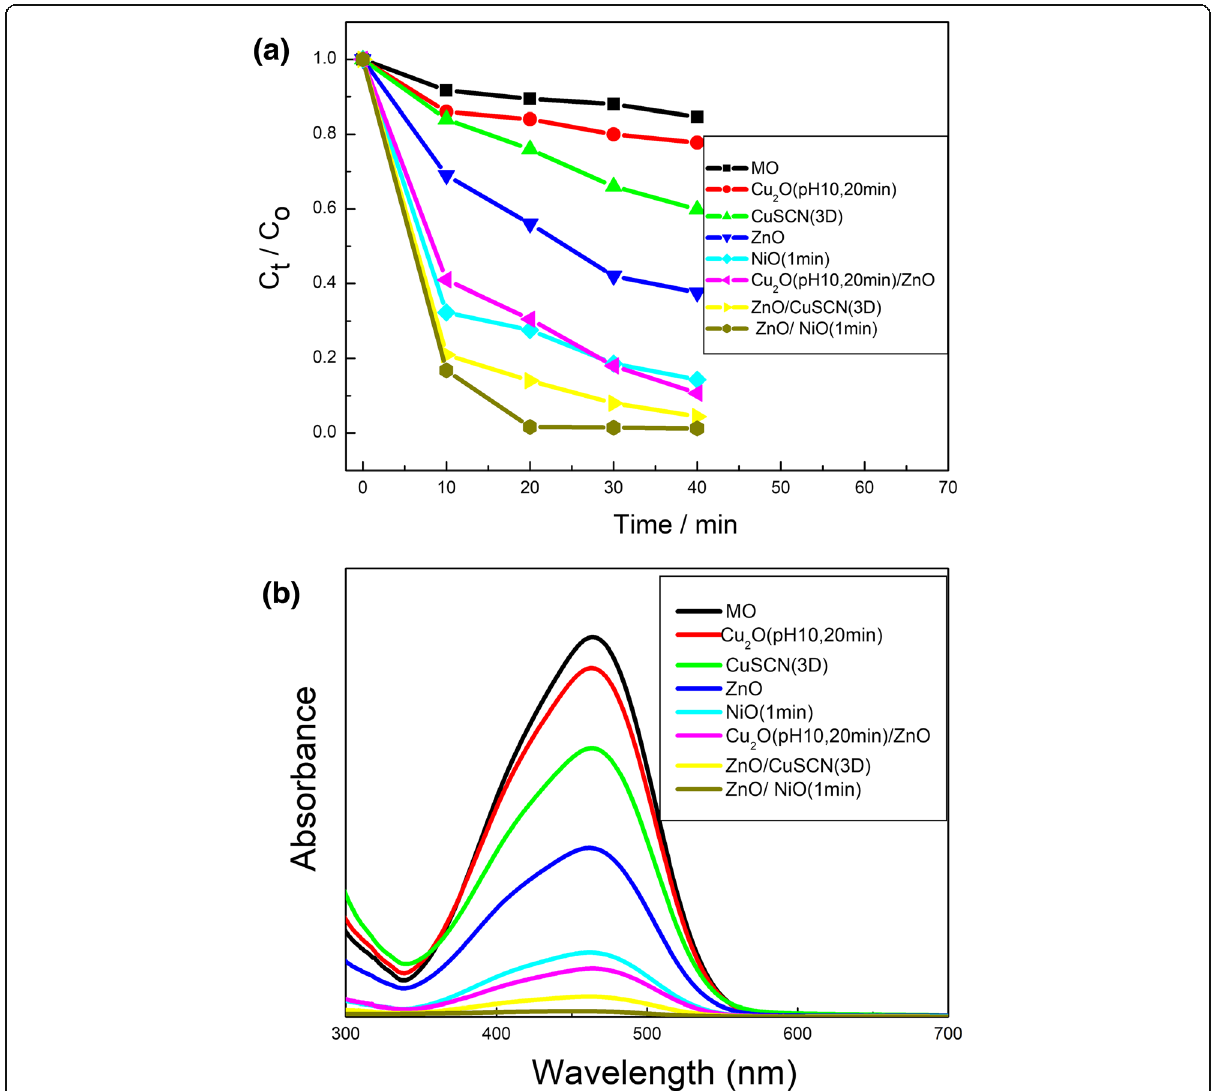
Fig. 6 a The relative concentration (C t /C 0 ) of MO versus time under light irradiation in the absence and presence of various photocatalysts: ZnO,